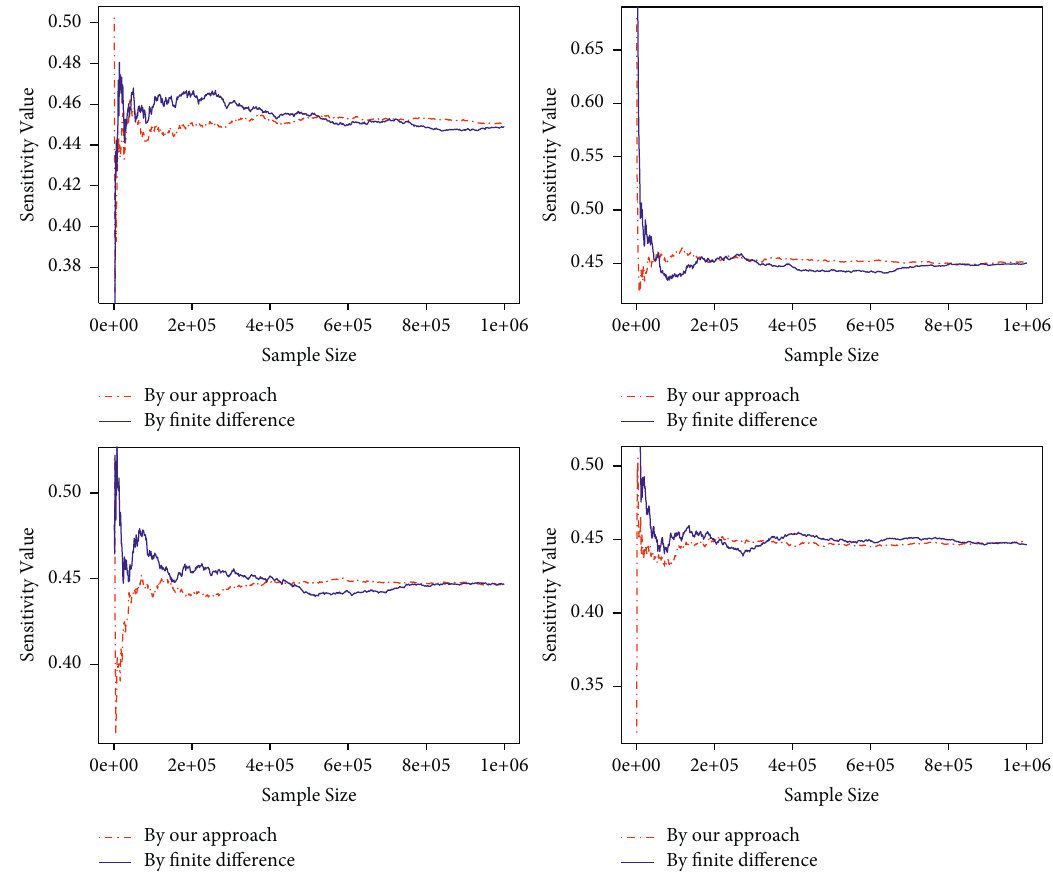
Figure 1: Comparison with finite